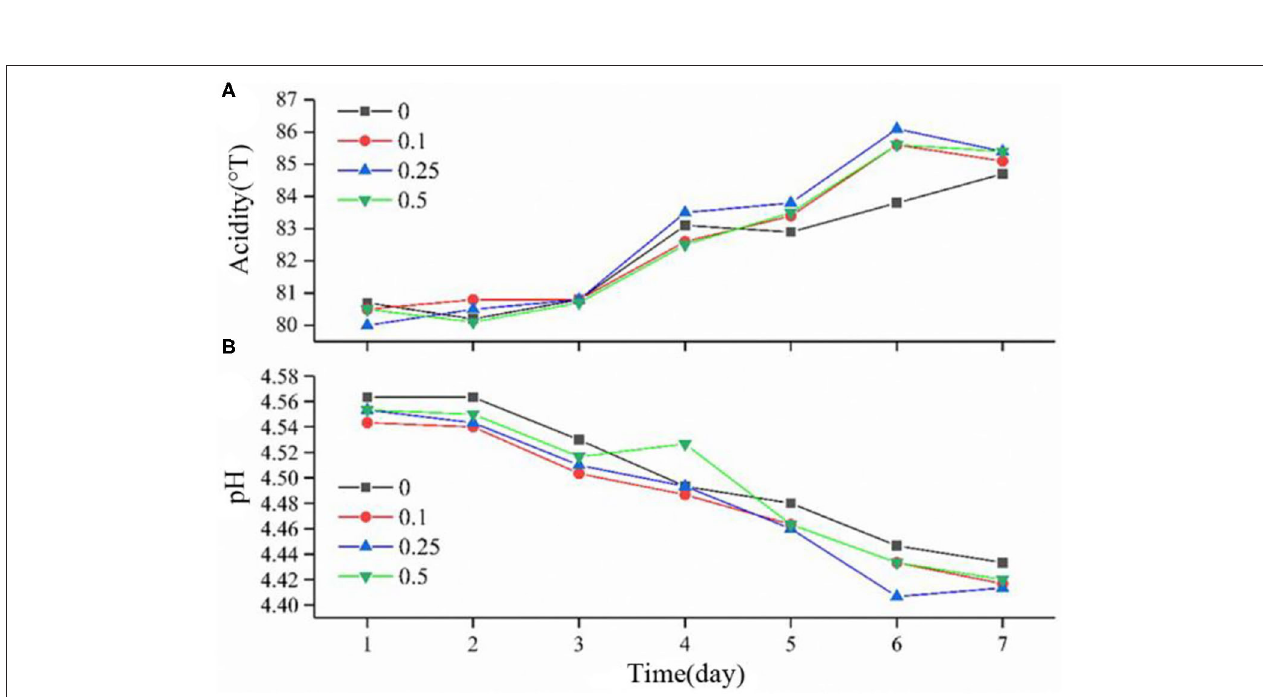
FIGURE 3 | pH (A) and titratable acidity (B) of yogurt during 7 consecutive days.